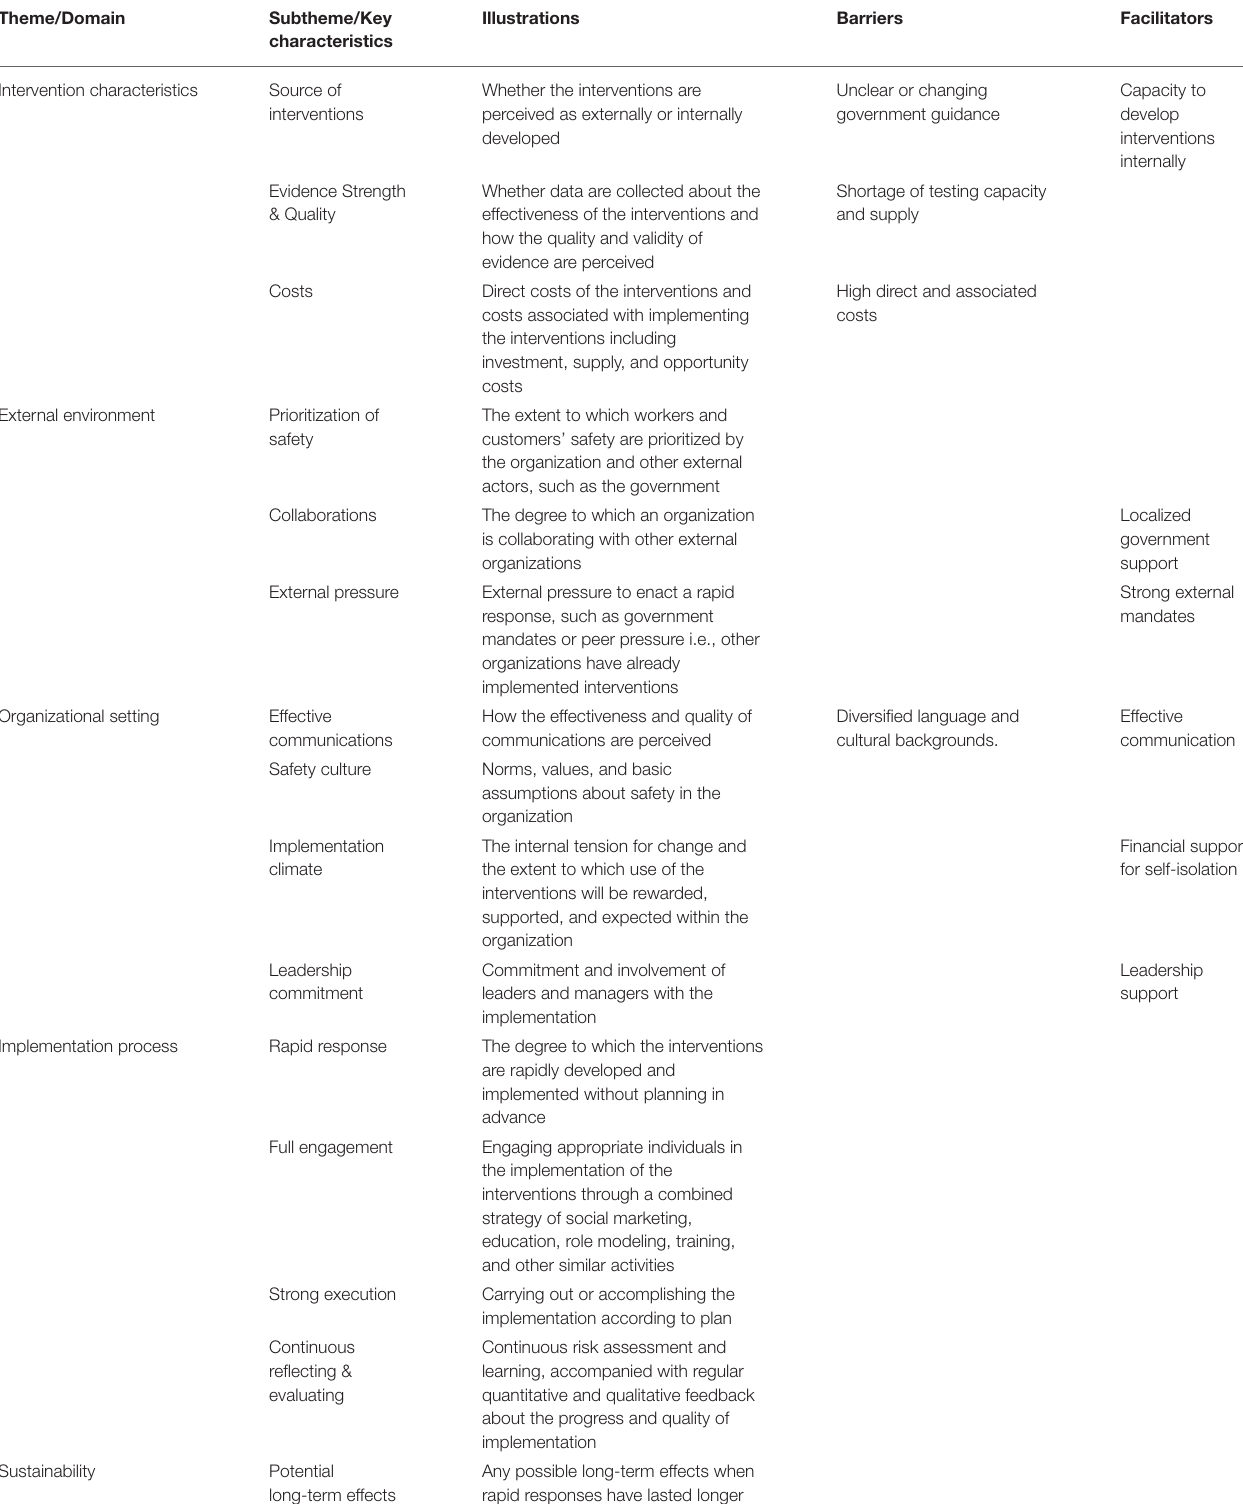
TABLE 2 | Rapid response process: COVID-19 – Logistics sector, adapted for evaluating a range of RMMs.